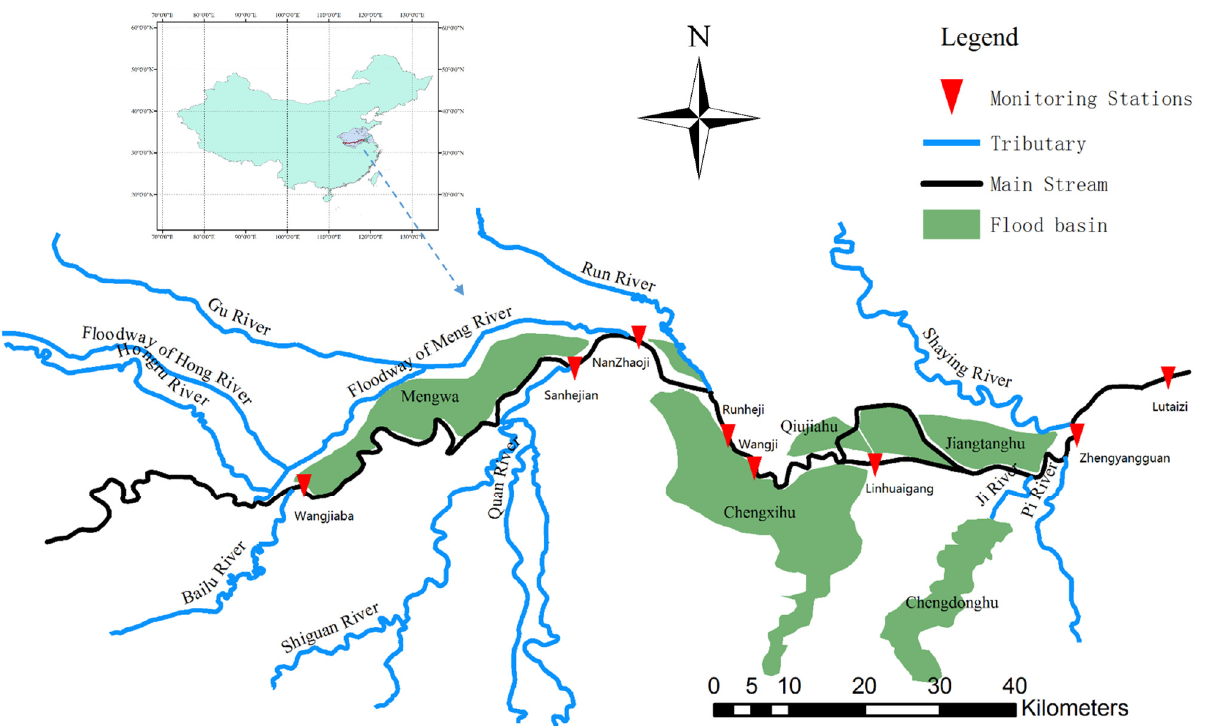
Figure 2. The branches of the Huai River and flood basins in the present study.